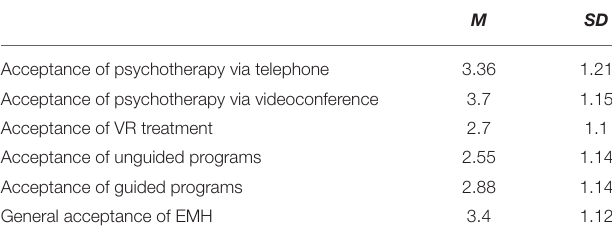
TABLE 1 | Means and standard deviations of EMH service